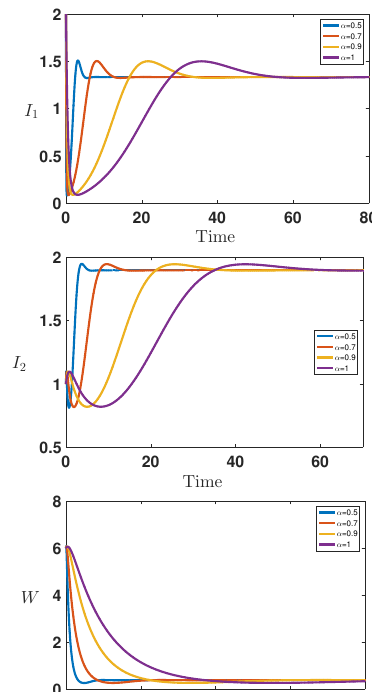
Figure 2. Behavior of the infection during the time for s 1 = 1, s 2 = 0.8, b 1 = 0.08, b 2 = 0.1, d 1 = 0.4, d 2 = 0.2, a 1 = 0.2, a 2 = 0.2, k 1 = 1, k 2 = 1.2, p = 0.3, r = 0.5, σ = 2.3 and q = 0.56, which correspond to the stability of the endemic equilibrium E 1 = ( 2.009,0.9807,2.4844,1.5155,1.2224,0 ) with R 0 = 1.4783 > 1 and R 1 = 0.8929 < 1.